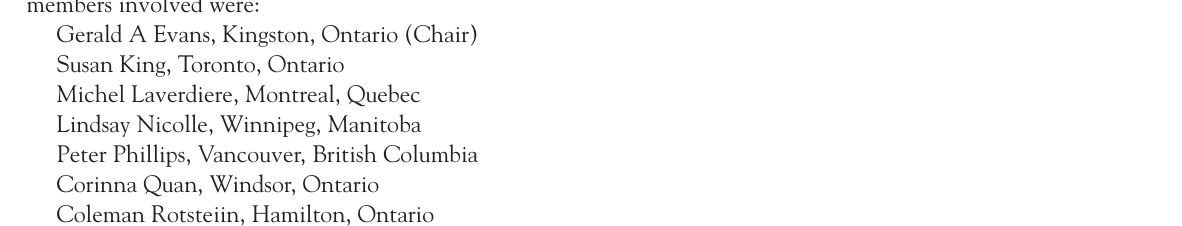
TABLE 3 Immunization schedule for children seven years of age and older not previously immunized in infancy (and still nonimmune)